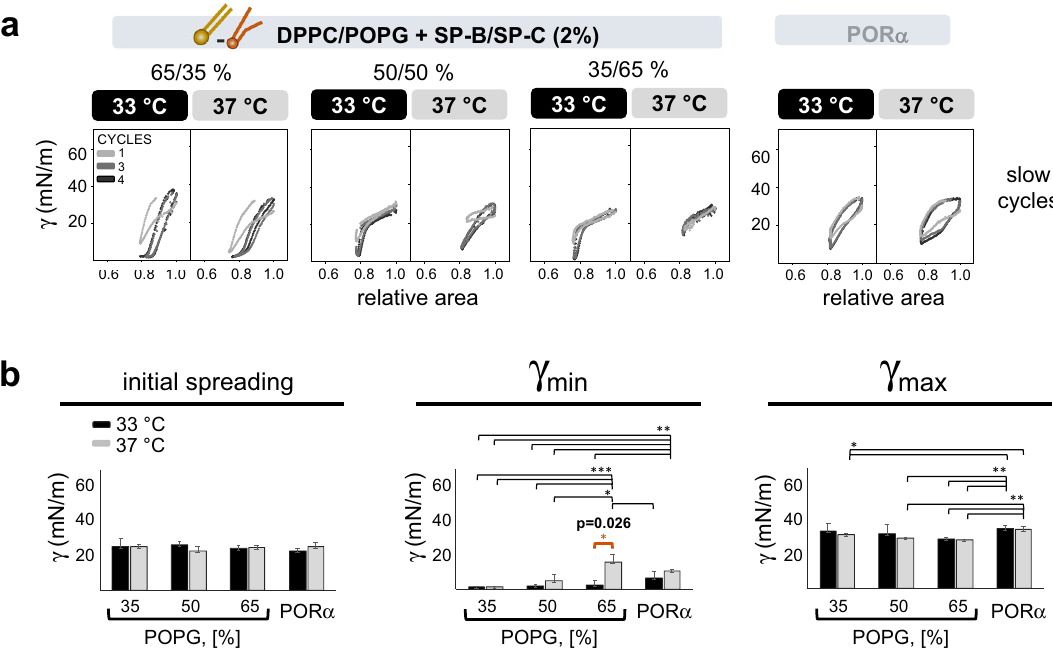
Figure 5. Temperature-mediated resistance to plasma inhibition, depending on DPPC/POPG ratio. About 200 nL at 40 mg/mL of PORα (n = 5 33 °C, n = 3 37 °C) or the lipid-protein mixtures [DPPC/POPG + SP-B/ SP-C (2% total protein-to-lipid by weight)] with increasing percentages of POPG (n = 3 for each mixture and temperature), were dispensed at the interface of plasma and subjected to 4 slow cycles in CDS (2 cycles/min, shrinking the interface area by 20%, 0.2 cm 2 /min). ( a ) One representative replicate of γ-∆area isotherms at the 2 temperatures for each tested material. ( b ) On the left, γ values reached after 10 s of material spreading at the plasma interface (initial spreading). In the middle and on the right, γ min and γ max reached during cycling. Compression-expansion cycles are depicted in grey scale. Black and light-grey bars represent experiments performed at 33 °C and 37 °C, respectively. Means and SD of at least three replicates are shown. Horizontal lines represent statistical comparisons. Two-way ANOVA test followed by post-hoc test = initial adsorption: (n. s.); γ min : temperature (p < 0.001, D.F. = 1, F = 20.5) and composition (p < 0.001, D.F. = 3, F = 11); γ max : temperature (n. s.) and composition (p = 0.003, D.F. = 3, F = 6.8). Paired t test = 65% POPG, γ min at different temperatures: p = 0.027, D.F. = 2, t = − 6. *p < 0.05 and > 0.01, **p ≤ 0.01 and > 0.005, ***p ≤ 0.005. The exact p values of the most relevant post-hoc tests are indicated. The corresponding comparison bars and symbols are highlighted in orange color. DPPC dipalmitoylphosphatidylcholine, POPG palmitoyloleoylphosphatidylglicerol, SP-B : surfactant protein B, SP-C surfactant protein C, PORα poractant α, γ surface tension, min minimum, max maximum, n. s. not significant, D.F. degrees of